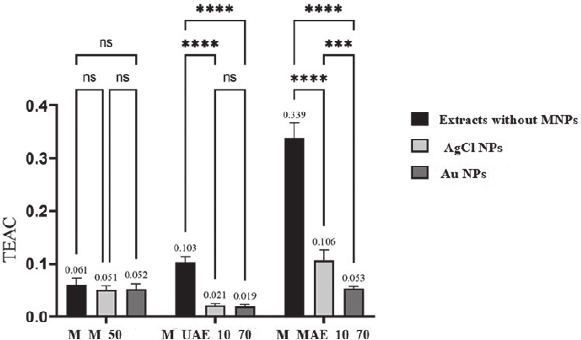
Figure 5. Trolox equivalent antioxidant capacity of simple extract and nanostructured phytochemical complexes of M. officinalis (Data are expressed as mean ± SD values from independent tripli- cate experiments and p values were calculated by one-way ANOVA followed by Šídák’s multiple comparisons test; ****p < 0.0001; ***p = 0.0003; ns p = 0.6144; 0.6707; 0.9953; 0.9814).